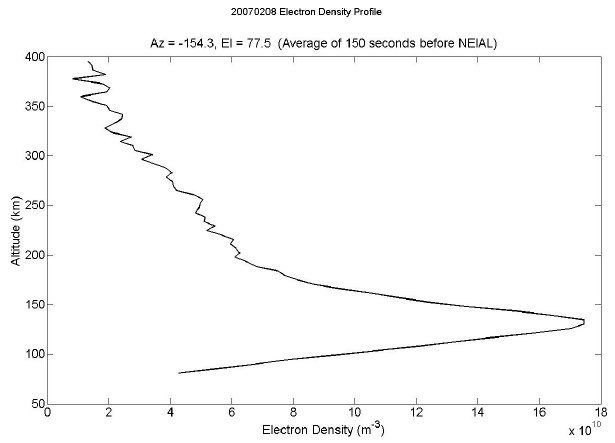
Fig. 8. The electron density (in m − 3 ) versus altitude for the 150 second period before the NEIAL event reported in Michell et al. (2008), showing that the winter, nightside ionosphere typically con- tains an enhanced E-region, but no significant F-region.